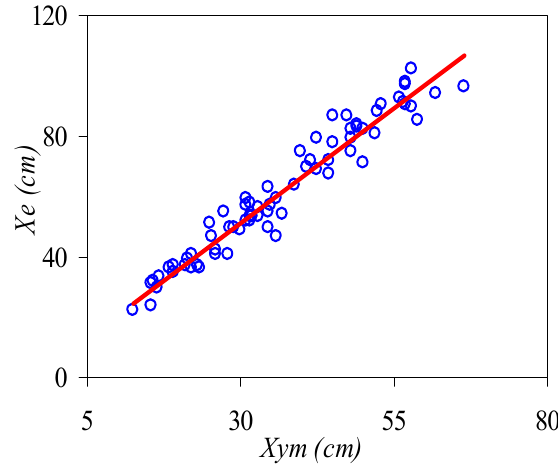
Figure 5. Relationship between horizontal distance to maximum jet edge level ( X ) for all experimental jet edge point ( X e